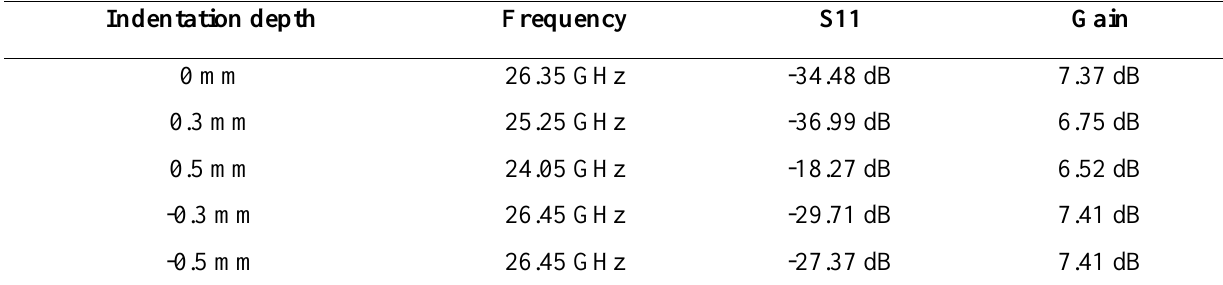
Table 2. Changing the indentations depth